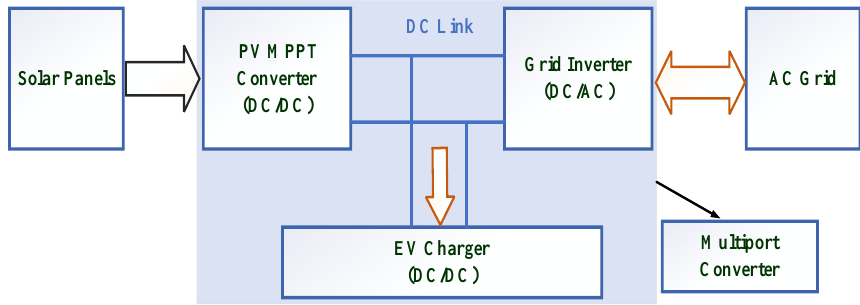
Figure 5. Multiport converter designs, the typical design of EV charging stations with integrated PV.